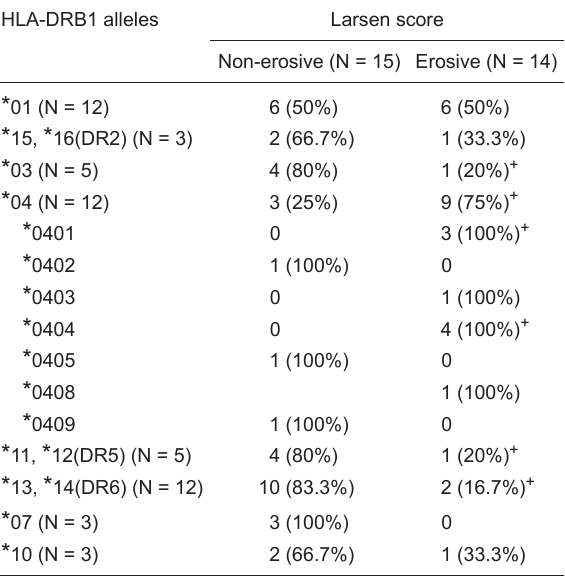
Table 5. HLA-DRB1 allele distribution among rheumatoid arthritis patients with erosive and non-erosive arthritis as determined by Larsen